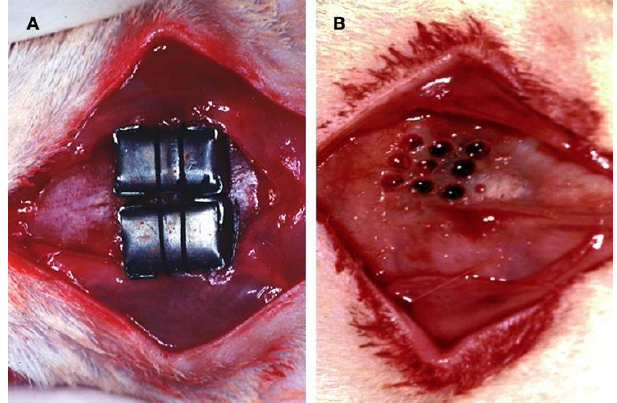
Figure 1. Surgical procedure: ( A ) Custom-made, smooth-surface, stiff caps of pure titanium were used as a barrier. The space inside was left empty for the graft to achieve bone augmentation. ( B ) The decortication procedure consisted of drilling nine holes into the outer layer of the cortical bone to induce active bleeding from the marrow space at the experimental sites.